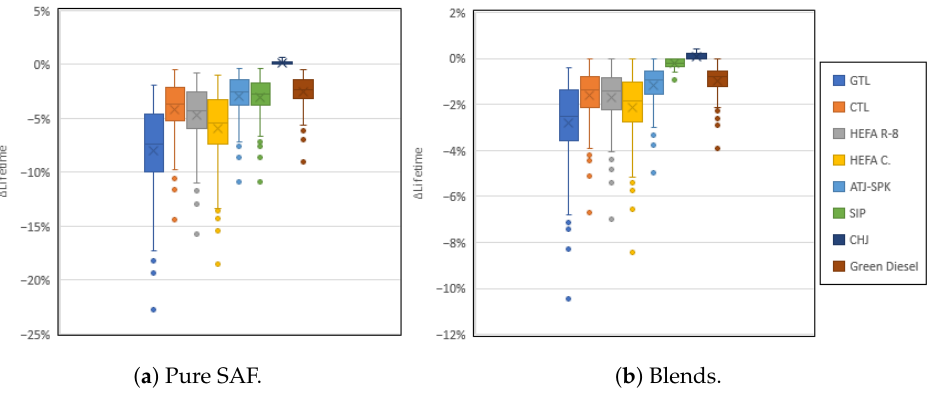
Figure 10. RDs in lifetime for reference contrails with lifetimes ranging from 30 min to 2